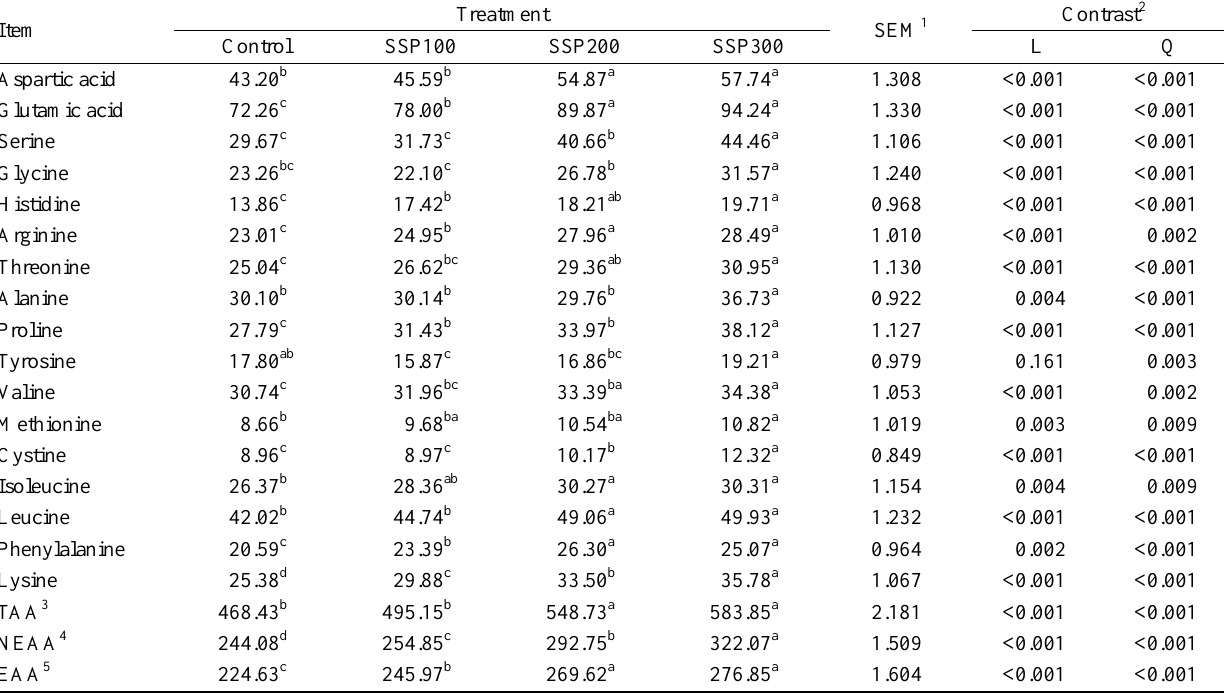
Table 6. Effects of soybean small peptide (SSP) infusion into rumen at the rates of 0 (Control), 100 (SSP100), 200 (SSP200) and 300 (SSP300) g/d on flux of amino acids at proximate duodenum of Luxi Yelow cattle (n =